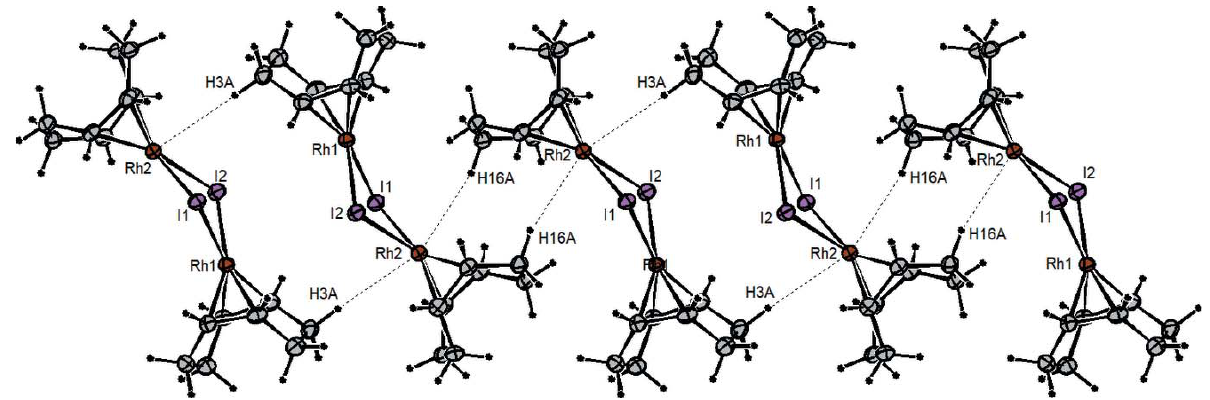
Figure 4 Diagram of [Rh( (cid:2) -I)(COD)] 2P showing weak intermolecular C—H (cid:3)(cid:3)(cid:3) Rh interactions between adjacent